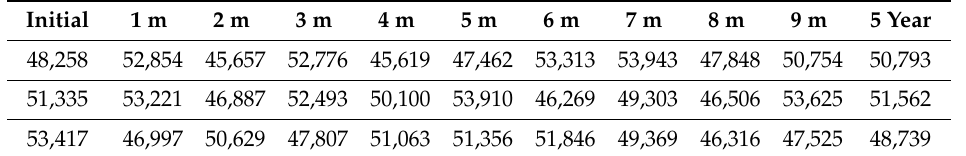
Table 2. Estimated pounding stiffness (unit N/m 1.5